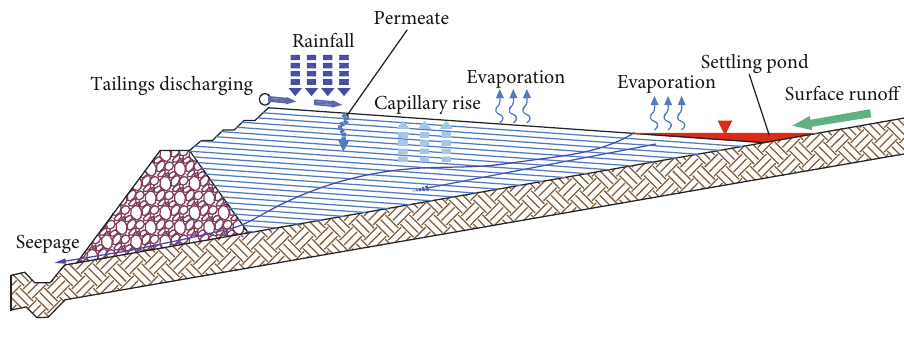
Figure 1: Complex hydraulic phenomena in tailing